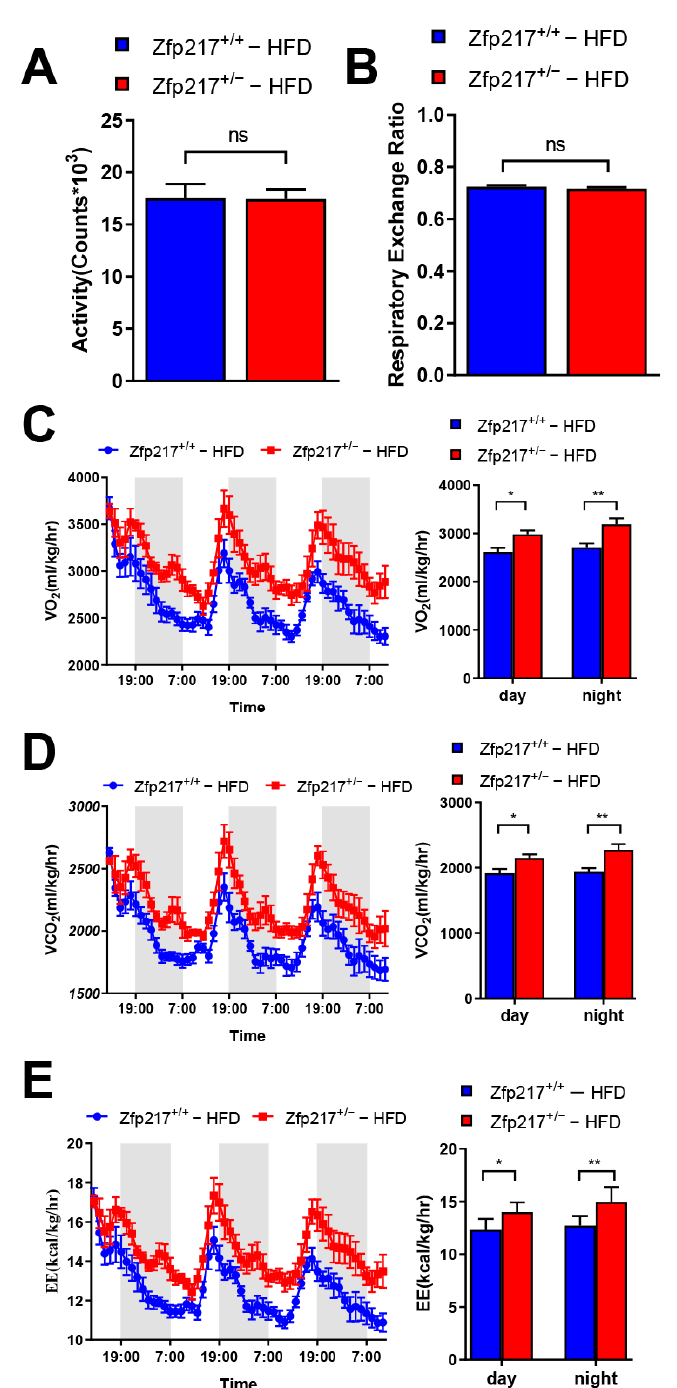
Figure 4. Zfp217 deficiency increases energy expenditure under HFD. ( A ) Physical activity, ( B ) Respiratory exchange ratio ( C ) Oxygen consumption (VO 2 ), ( D ) Carbon dioxide generation (VCO 2 ), and ( E ) Energy consumption analyzed by indirect calorimetry in Zfp217 +/+ and Zfp217 +/ − mice after HFD feeding at 25 weeks ( n = 6 per group). For all statistical plots, data are presented as the mean ± SEM. * p < 0.05; ** p < 0.01; ns indicates no significance between the two indicated groups.